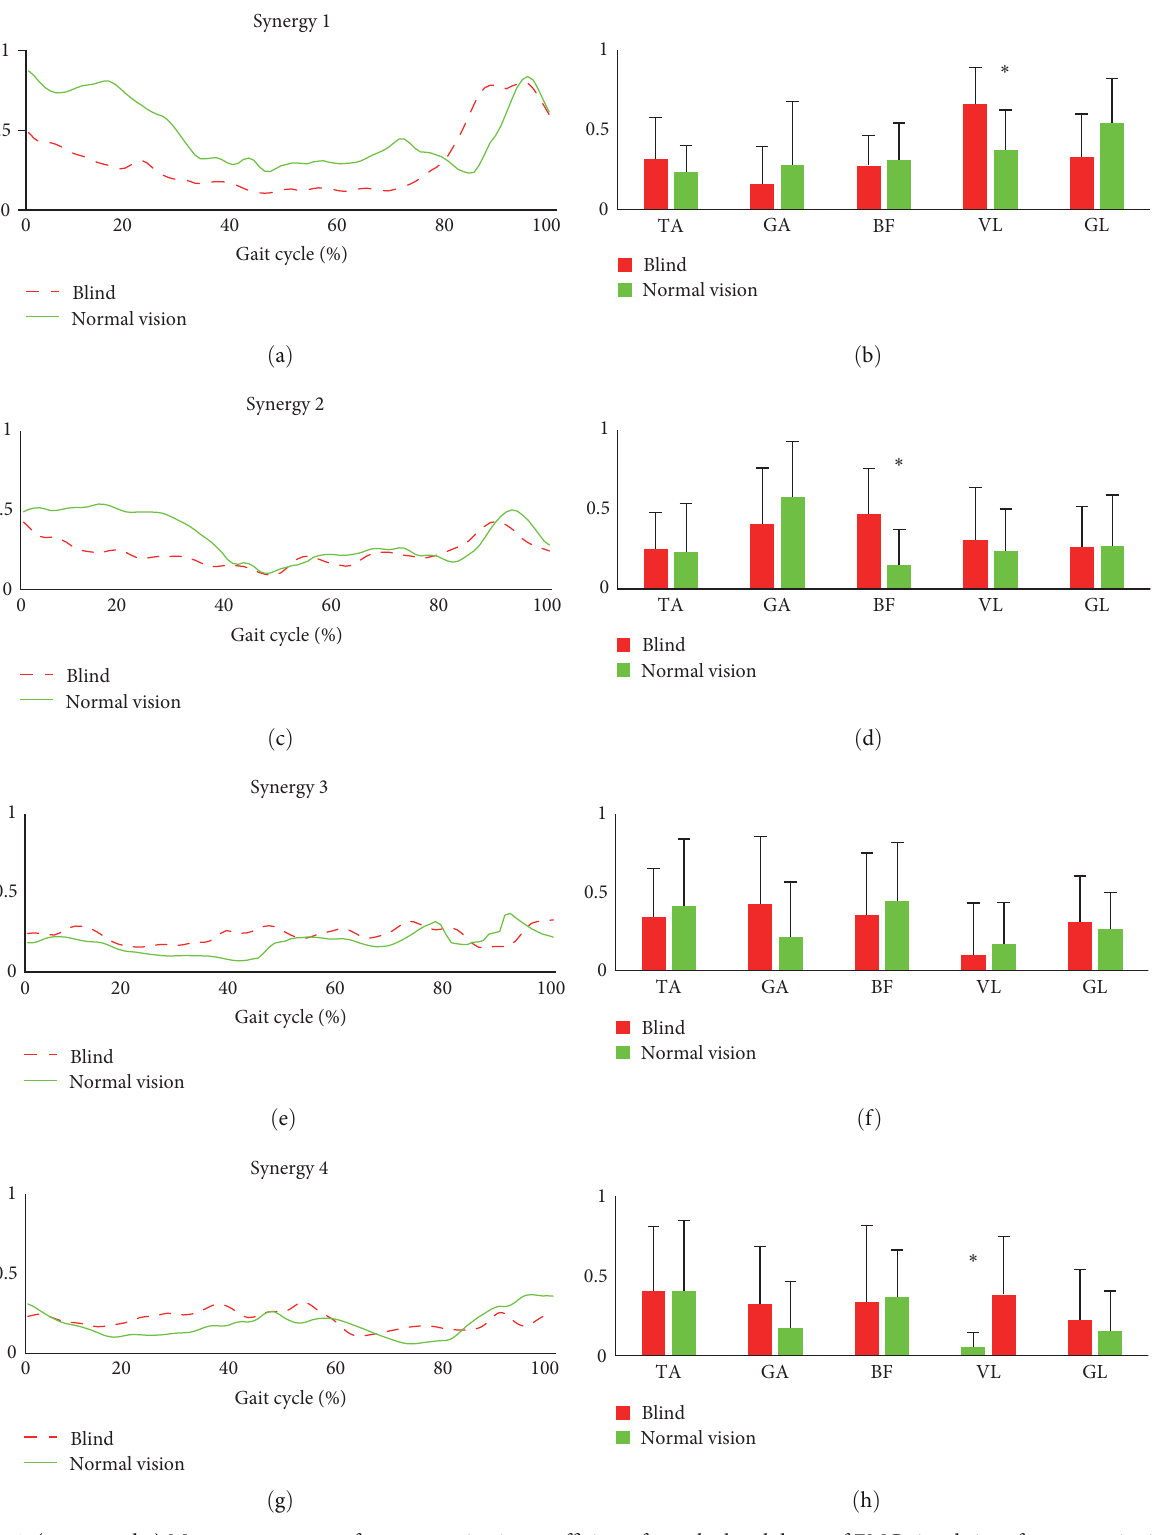
F IGURE 1: (a, c, e, and g) Mean components of synergy activation coef fi cients from the breakdown of EMG signals into four synergies in the groups with normal vision and blind subjects; (b, d, f, and h) mean values of muscle synergy with standard deviation in the two groups with normal vision and blind subjects ( ∗ shows a signi fi cant difference in P < 0 :